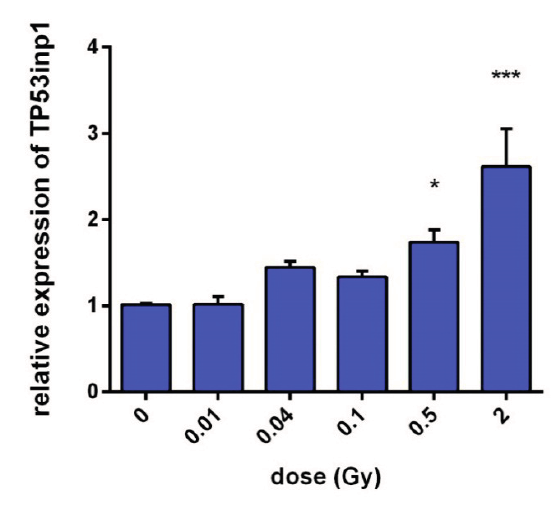
Figure 1. Dose-dependent expression of TP53inp1 in immortalized human fibroblast cells (F11hT). Relative gene expression was measured by qPCR with the delta-delta cycle threshold ( ΔΔ C t ) method as described in the Experimental Section. The data are derived from at least three independent experiments, and error bars show SEM of the mean. Gene expression in the F11hT cells is expressed in comparison with the sham-irradiated fibroblasts cells (calibrators), in which levels of expression are regarded as a level of one. Cells were harvested 2 h after γ -irradiation. One-way ANOVA was used for analysis. ( * p < 0.05, *** p <